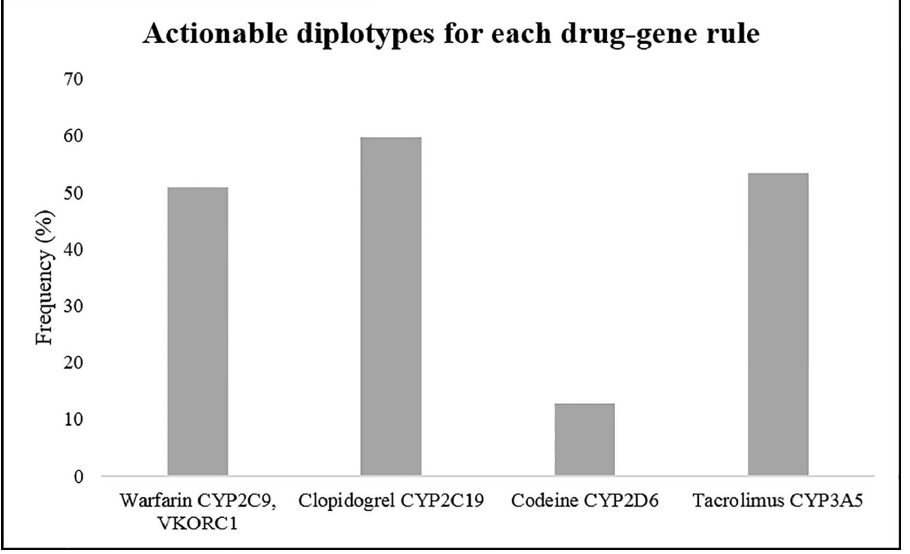
Fig 2. The frequencies of actionable diplotypes for each drug-gene rule. The definitionof actionable diplotypes is definedas follows: (i) warfarin, CYP2C9 * 2 or * 3 heterozygote or homozygote with VKORC1 GA or AA genotypeand CYP2C9 * 1with VKORC1 AA genotype; (ii) clopidogrel,CYP2C19 * 2, * 3 and * 6; (iii) codeine, CYP2D6 poor and intermediate metabolizers; (iv) tacrolimus, CYP3A5 * 1 heterozygote or